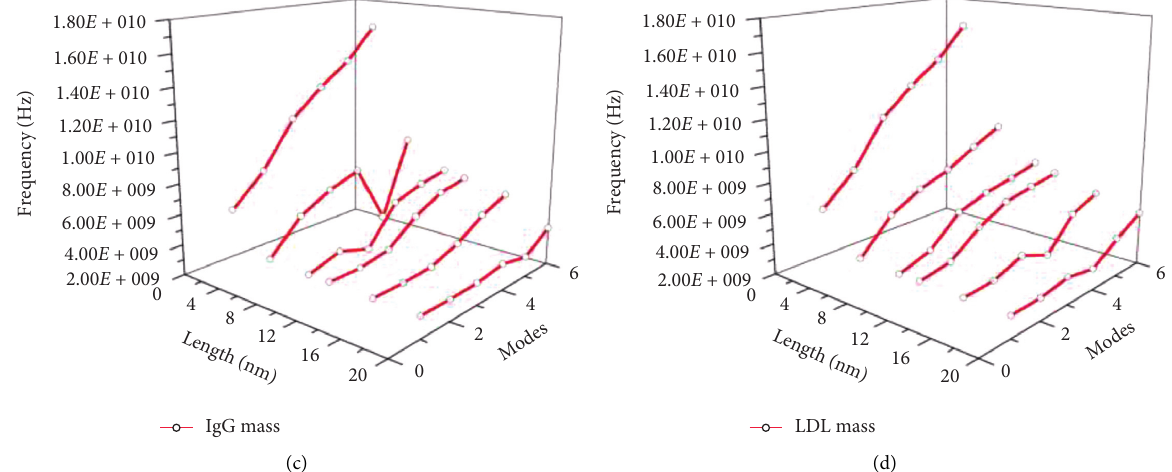
Figure 7: (a) Fixed-free boundary fundamental frequency for CNT with no mass and frequency shift analysis for (b) insulin, (c) IgG, and (d) LDL biological objects mass attached.